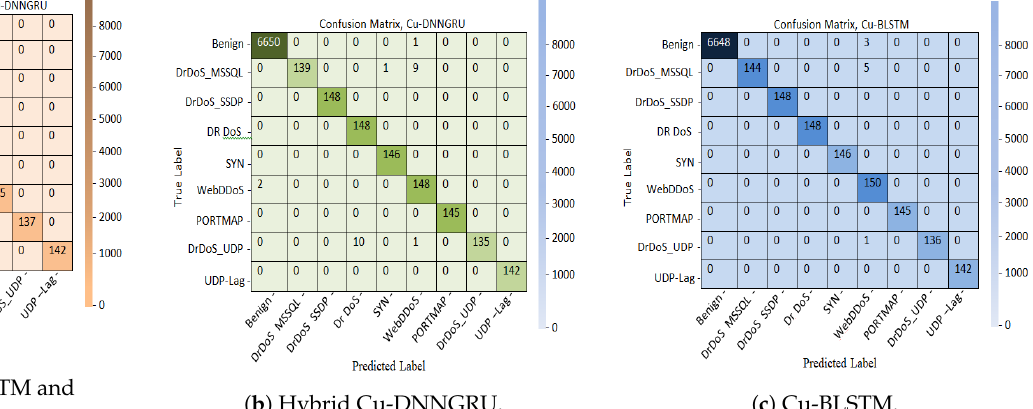
Figure 3. Confusion